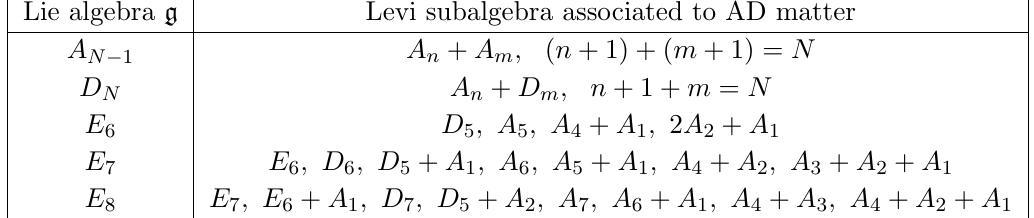
Table 7 . Possible Levi subalgebra for T ‘ that corresponds to AD matter without exact marginal deformations.